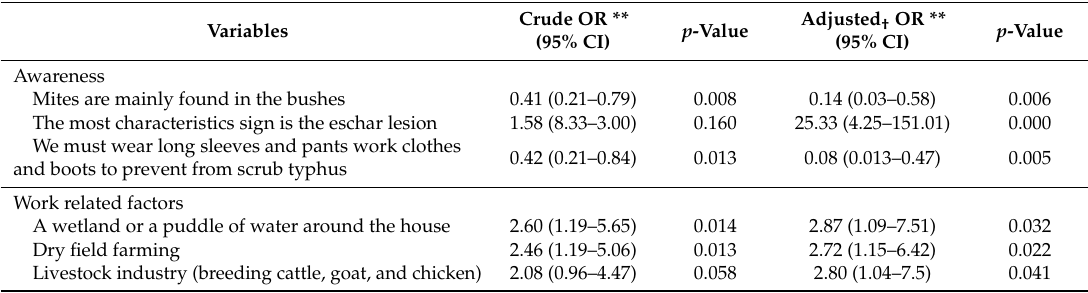
Table 4. Associations between scrub typhus contraction and disease awareness and work-related factors as determined by multivariate analyses